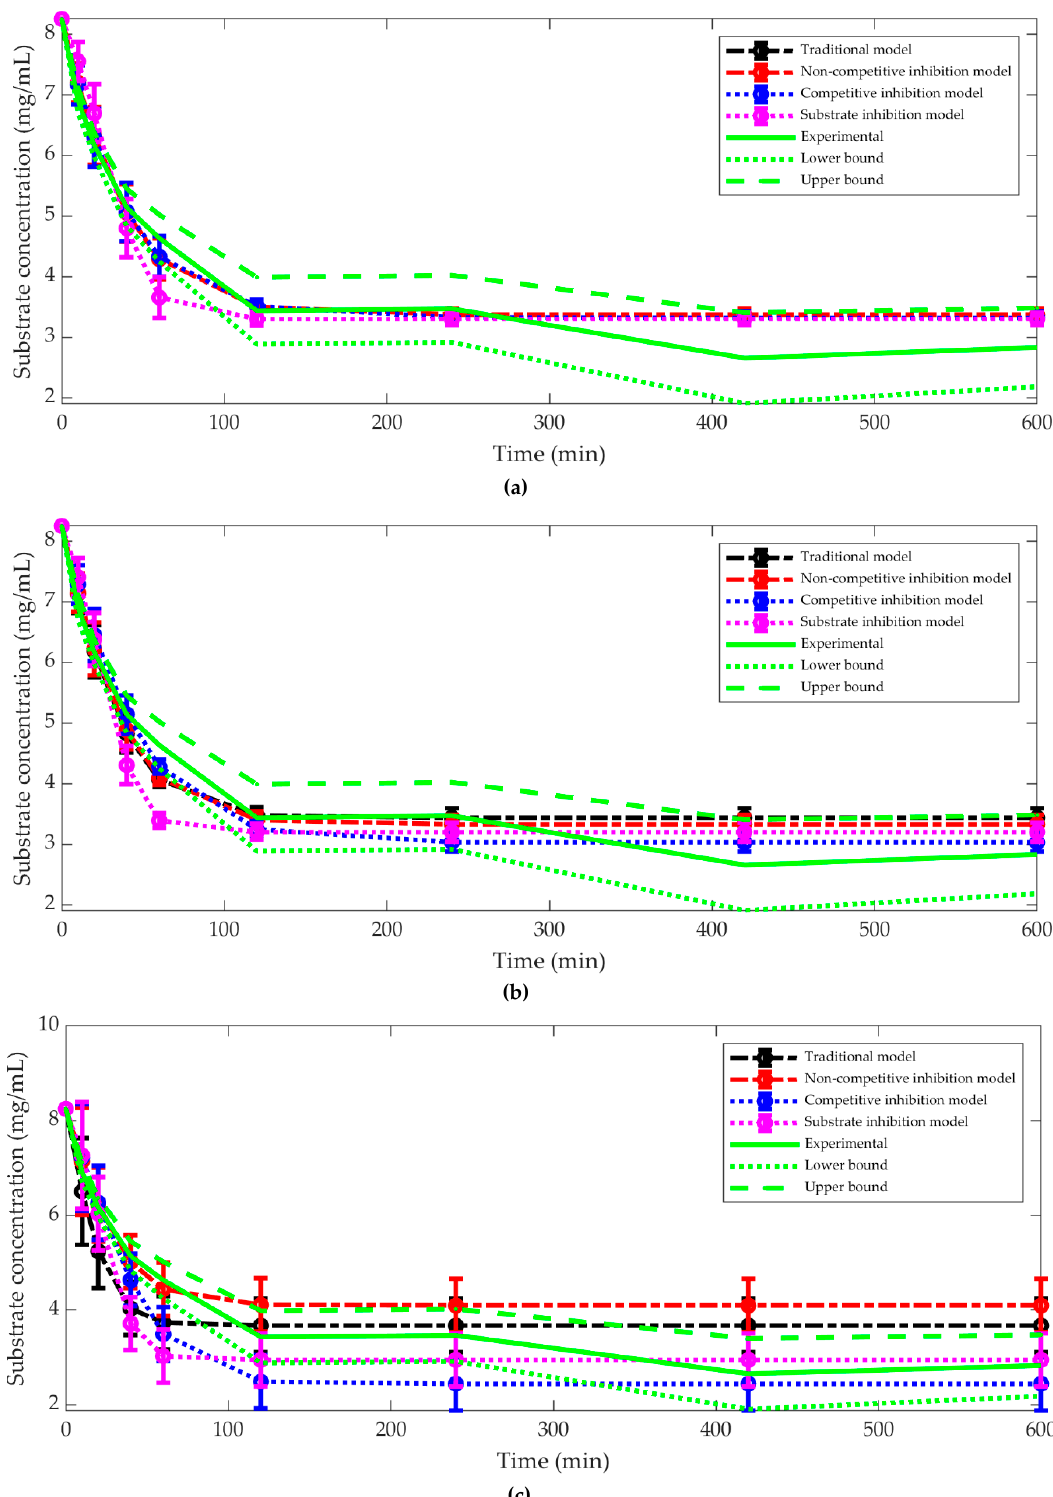
Figure 5. Graphical comparison of the four M–M models calibrated by four optimization strategies: ( a ) Interior-Point Algorithm; ( b ) Particle Swarm Optimization and ( c ) Univariate Marginal Distribution Algorithm. Experiment 13 at pH = 5; T = 55 °C; enzyme–substrate ratio = 1.8 μ L of enzyme/g of substrate.